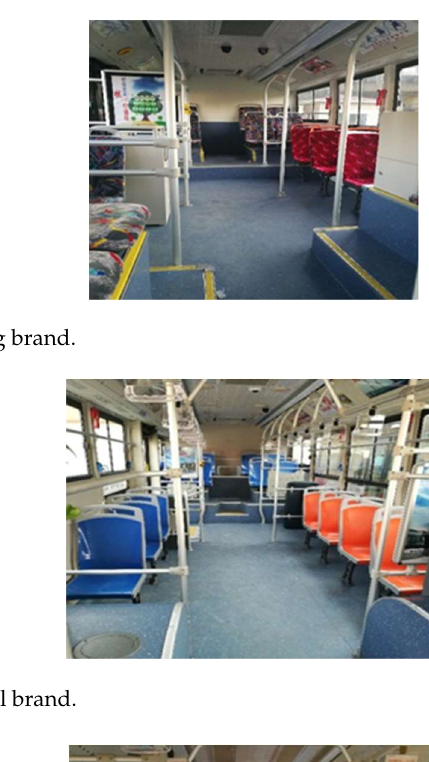
Figure 1. BYD brand.